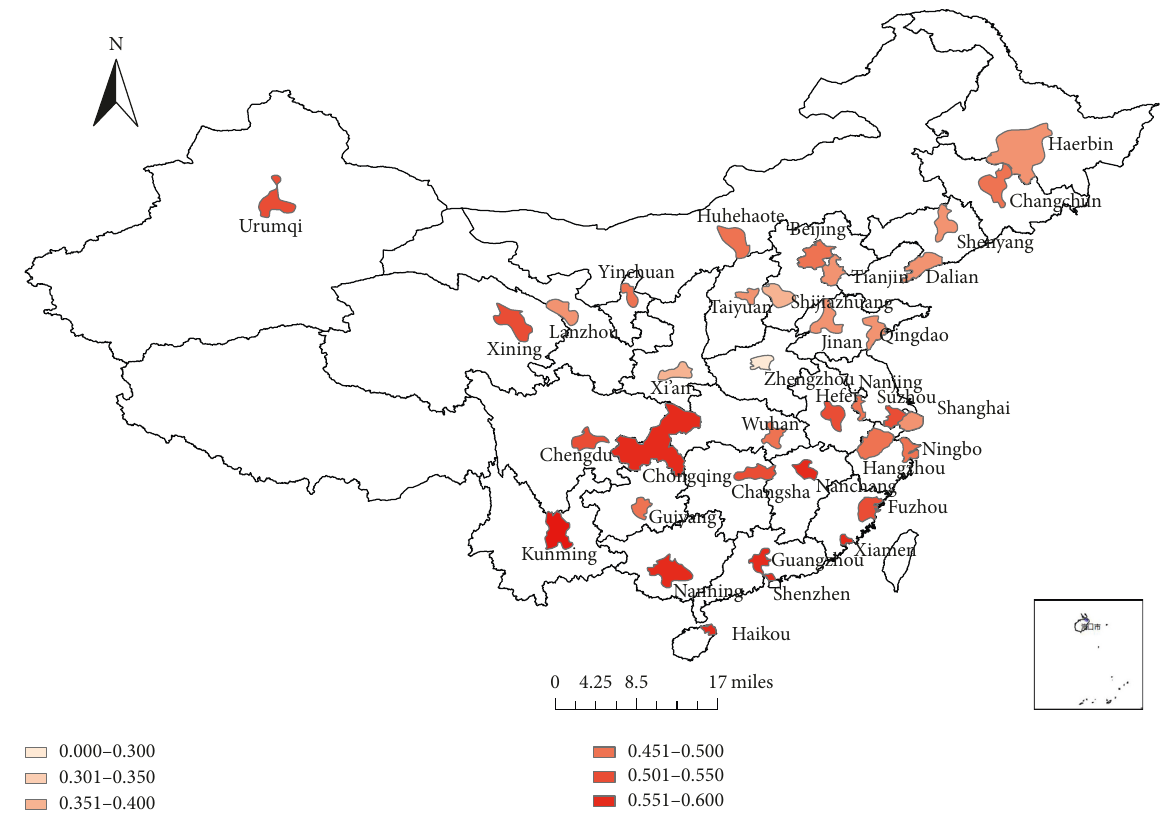
Figure 4: Spatial distribution of 36 main cities’ UPE scores in 2016.